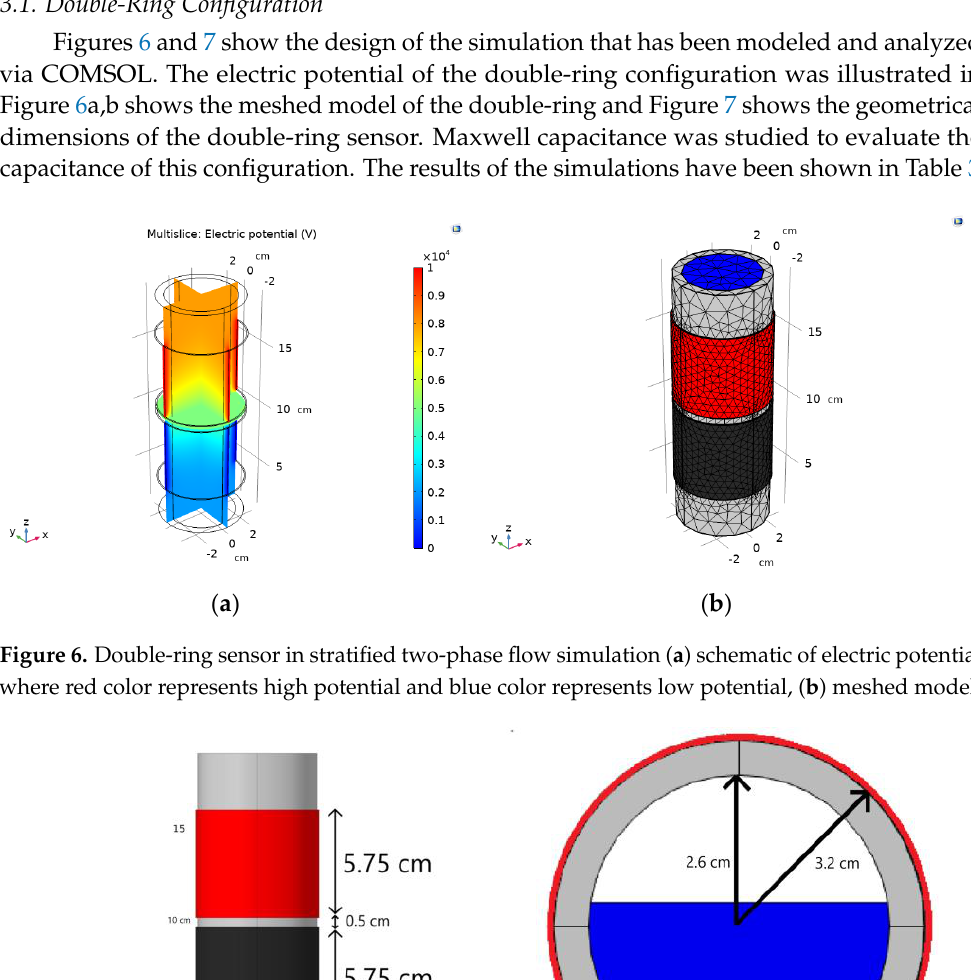
Figure 5. Different water levels in the cross-section of the pipe for a different void fraction in COM- SOL, where the blue color represents the water level, the gray color represents the pipe, and the red and black colors represent the electrodes.